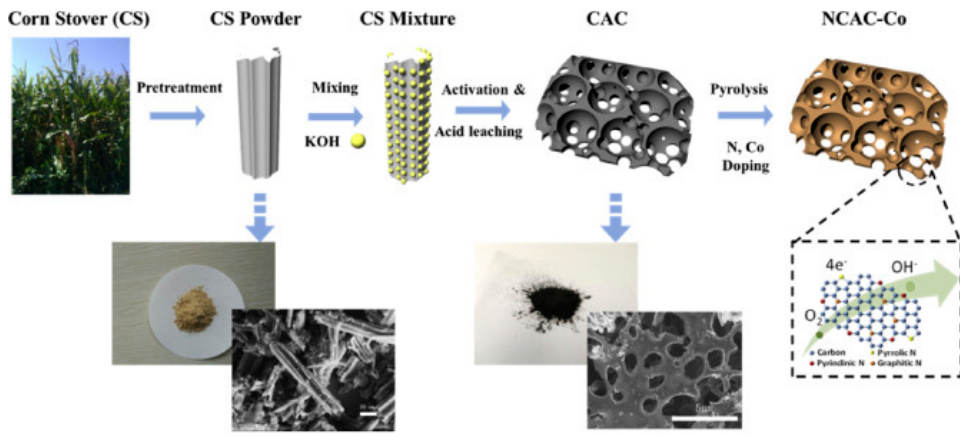
Figure 10. Schematic diagram for synthesis of N and Co, codoping NCAC-Co. Adapted from [175], with permission from Energy , 2018.